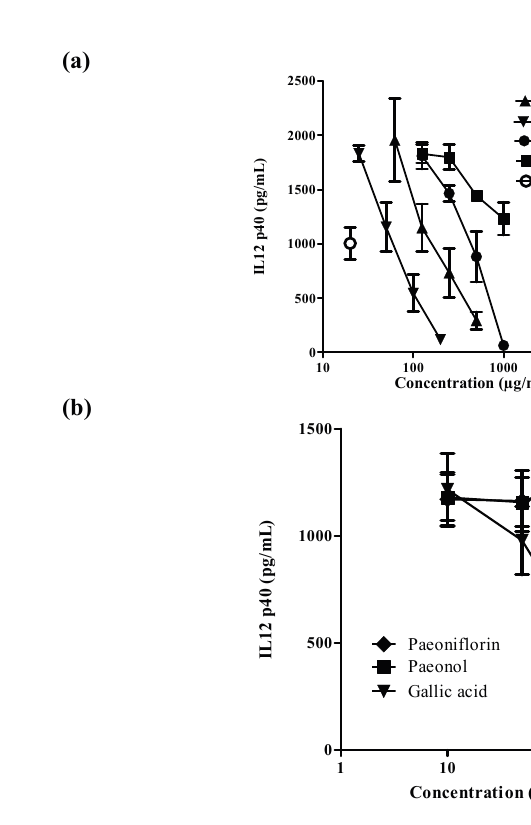
Figure 3. The effects of the active ingredients from Moutan Cortex on IL-12p40 production from human monocyte derived dendritic cells (moDC) ( n = 3). ( a ) The Effects of fraction 5 (F5) and gallic acid were compared to the crude water extracts of Cortex Moutan and Penta Herb formula (PHF) on IL-12p40 production from human moDC, and hyrodocotroisone (2 μ M) was used as positive control; ( b ) The effects of three active ingredients from Cortex Moutan: paeoniflorin, paeonol and gallic acid on IL-12p40 production from human moDC. * and *** indicate p < 0.05 and p < 0.001, respectively, when compared with the control level of the cytokine production or surface marker expression from cells without incubating with DC-inducing cytokine